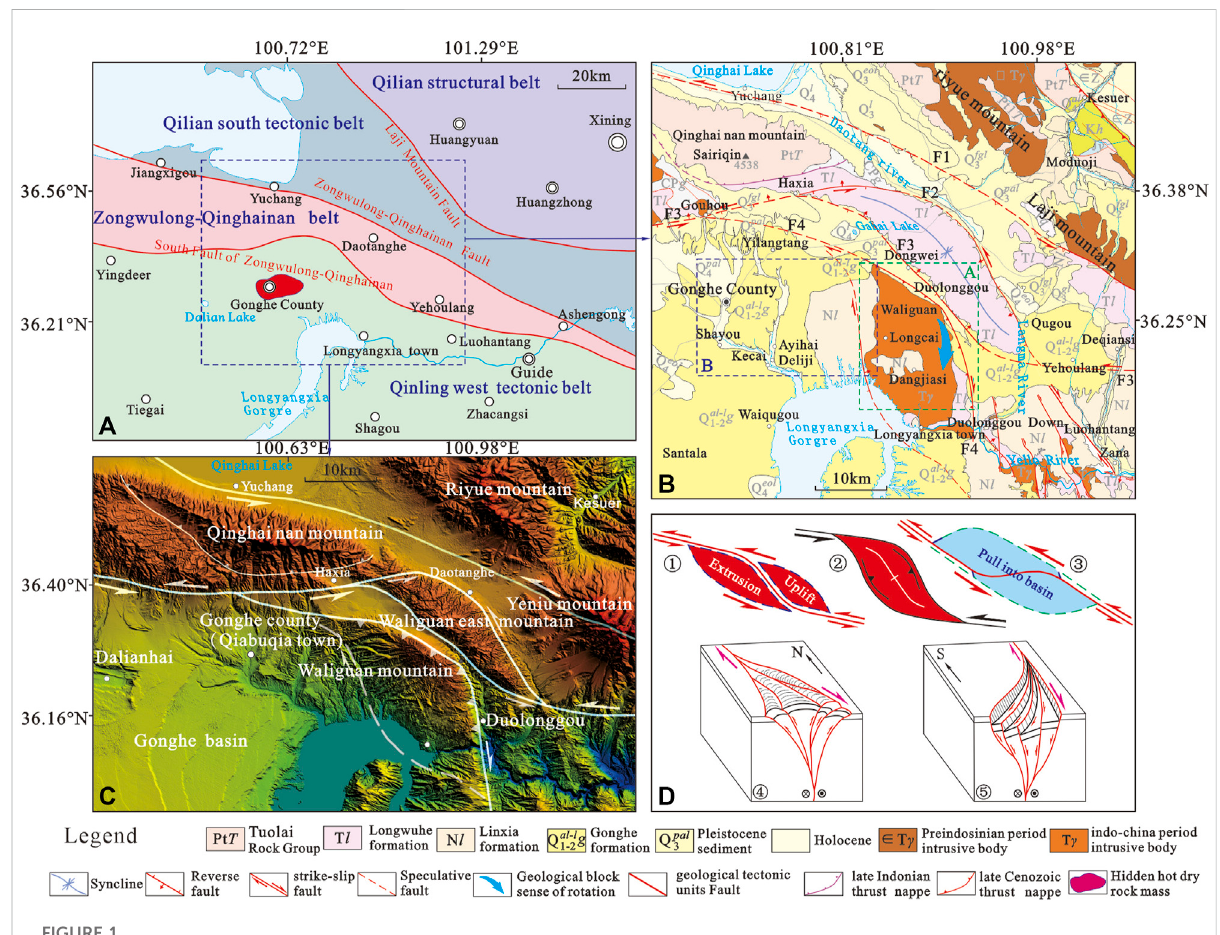
FIGURE 1 (A) Geological map of the Qiabuqia area showing major tectonic unit divisions; (B) regional geological map of the Qiabuqia area; (C) digital elevation model (DEM) and distribution map depicting main boundary faults; and (D) diagram of geomorphological changes caused by strike-slip fault bending ( ① restricted bending of the left strike-slip fault to form the strike-slip-squeezing uplift at Yeniu Mountain, ② strike-slip-squeezing uplift caused by paired low-curvature restricted bending of the Waliguan and East Waliguan Mountains, ③ fusiform – rhombus composite pull- apart basin formed when the left-lateral strike-slip fault bending stress was released, and ④ + ⑤ horsetail structure at the end of thestrike-slip fault: ④ compressional horsetail structure and ⑤ stretching the horsetail